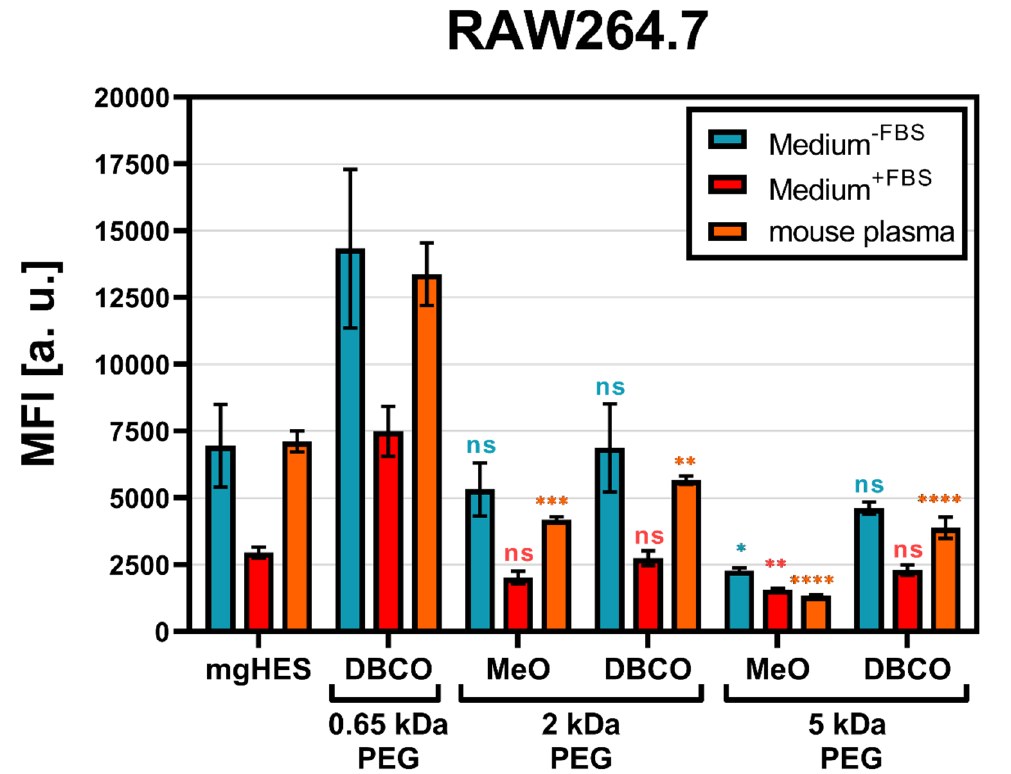
Figure 2. Longer PEG chains reduce nanocarrier uptake by RAW264.7 cells . Nanocarriers were incubated with RAW264.7 cells in either a medium with or without FBS, or pre-incubated with mouse plasma with a sample concentration of 75 µg mL − 1 and incubated for 2 h at 37 °C. Autofluo- rescence was subtracted from each data set. Only viable cells were analyzed. Values are given as mean ± SD ( n = 3). Each PEGylated sample was compared to the pristine nanocarrier group (mgHES) and significance was given with p < 0.05 using a one-way ANOVA followed by a Dunnett’s multiple comparison test. ns = not significant, p < 0.05 *, p < 0.01 **, p < 0.001 ***, p < 0.0001 ****.